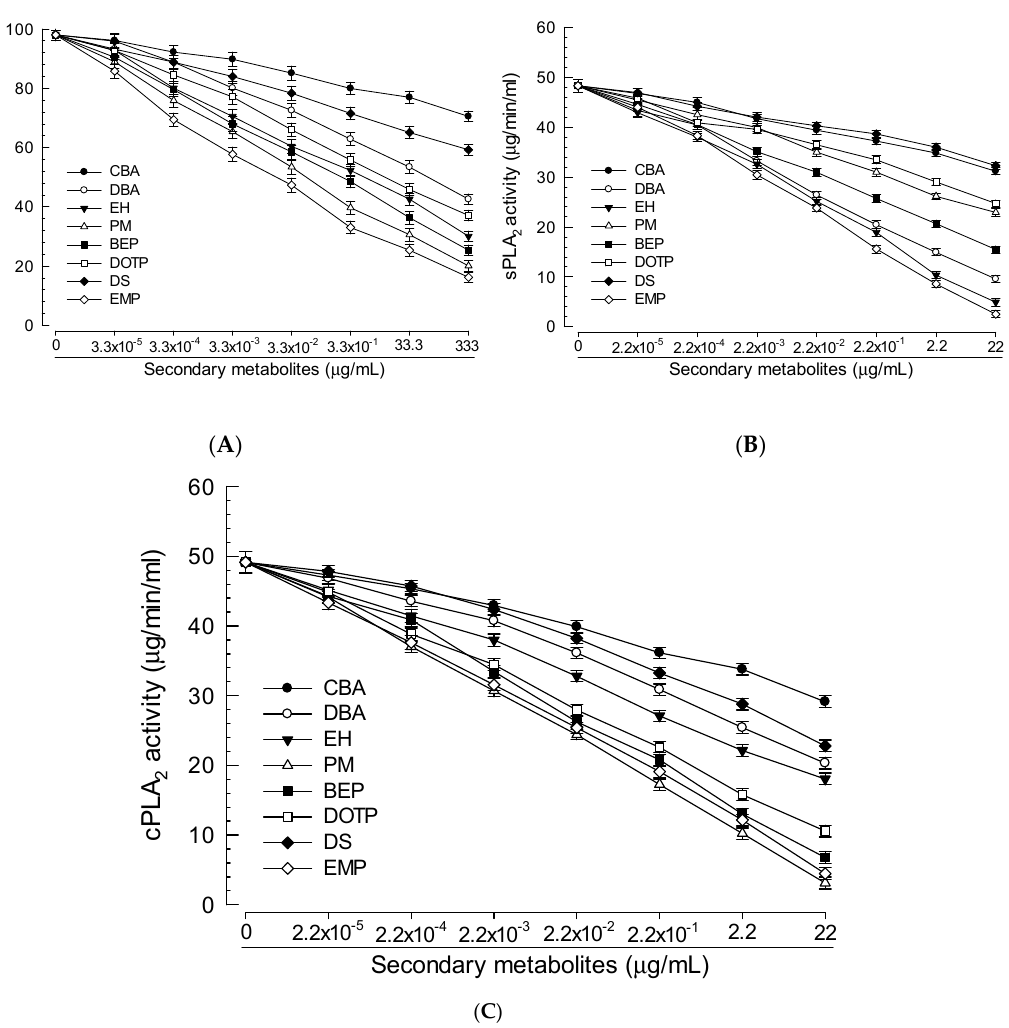
Figure 4. Inhibitory activity of bacterial secondary metabolites against three different PLA 2 activities of S. exigua : nonspecific PLA 2 ( A ), secretory PLA 2 (sPLA 2 ) ( B ), and cytosolic PLA 2 (cPLA 2 ) ( C ). The eight compounds are bis(2-ethylhexyl) phthalate (BEP), o-cyanobenzoic acid (CBA), dibutylamine (DBA), dioctyl terephthalate (DOTP), docosane (DS), 2-ethyl-1-hexanol (EH), 3-ethoxy-4-methoxyphenol (EMP), and phthalimide (PM). Each measurement was replicated three times with three independent samples. Table 1. PLA 2 -inhibitory activities of eight compounds identified from X. hominickii culture broth. Compounds 1